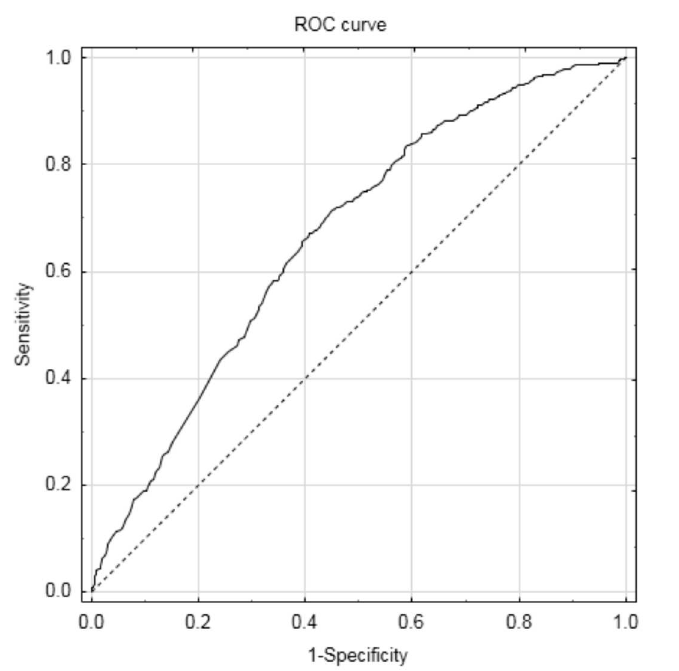
Figure 2. The ROC Curve for the created artificial neural network model (after PCA)